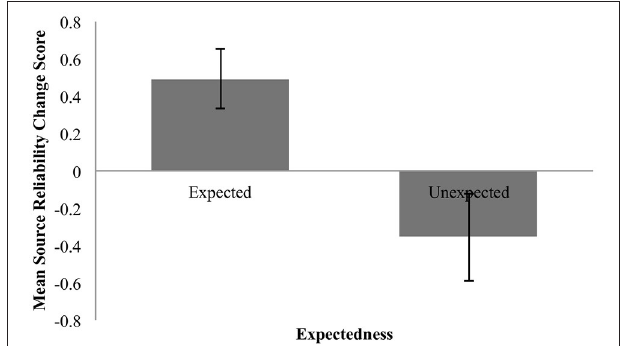
FIGURE 7 | Posterior distributions of effect size for belief change from reliable sources (A) and unreliable sources (B) . ROPE from − 0.1 to 0.1. Black bar represents 95% HDI.